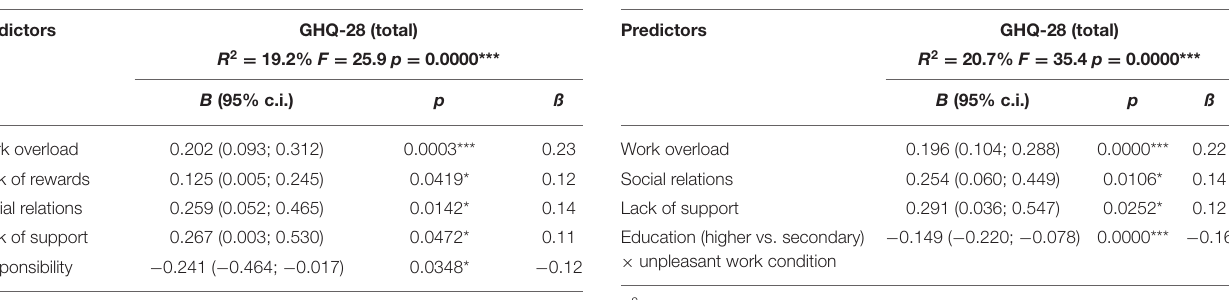
TABLE 7 | The effect of partial psychometric measures SWEQ on the overall mental health level.